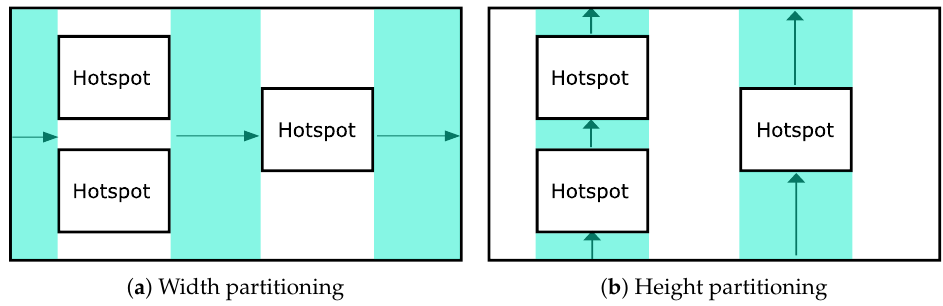
Figure 8. An example of the remaining regions’